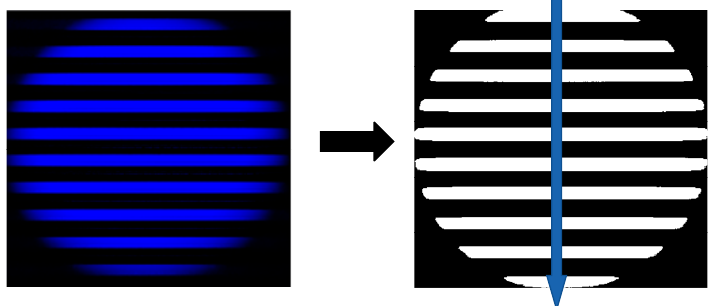
Figure 11. Get the duty-ratio of the bright stripes and the number of stripes.